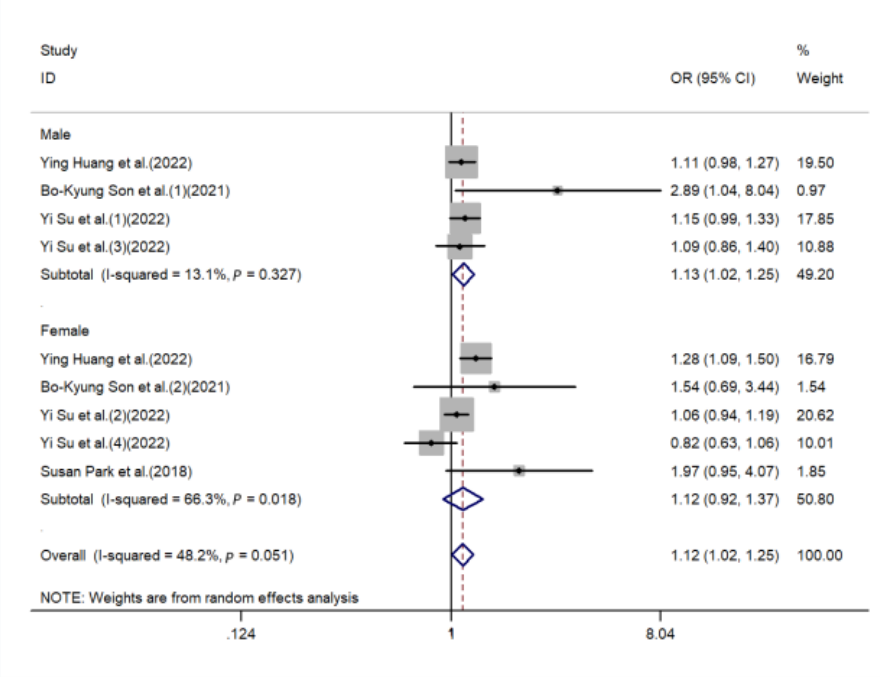
Figure 4. Forest plot for the subgroup of performance of sarcopenia [19,21-25] .